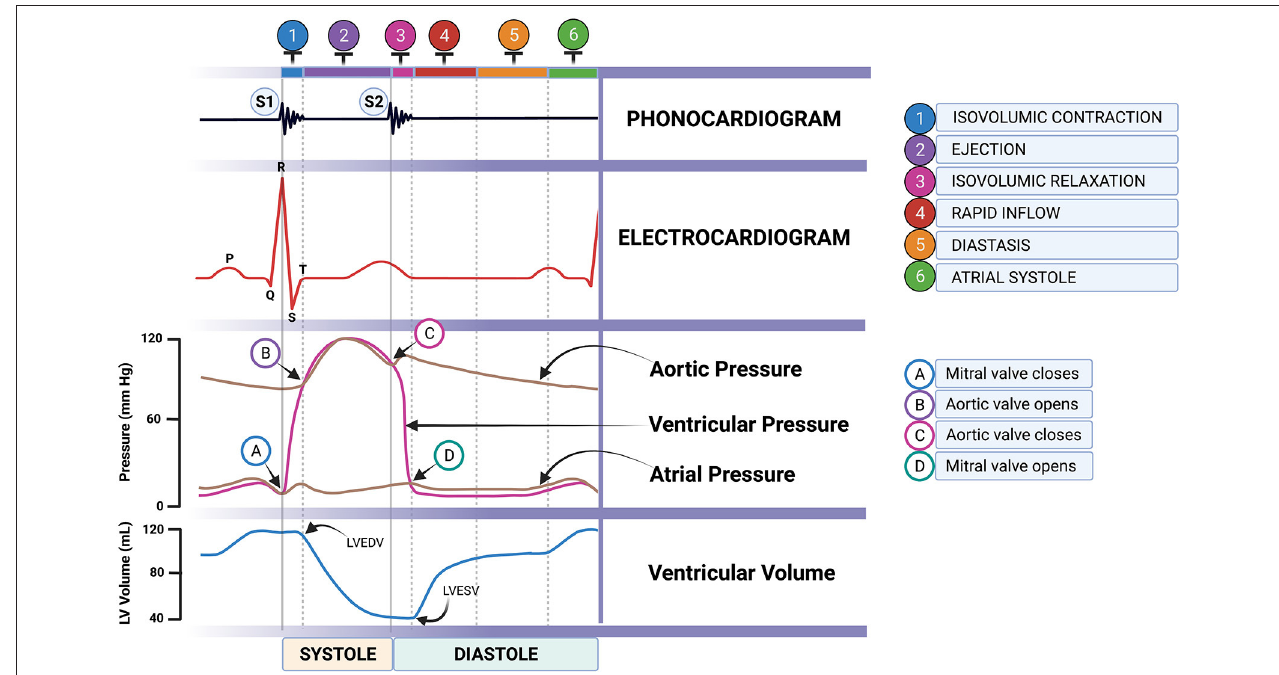
FIGURE 1 | Cardiac cycle through the Wiggers diagram showing the simultaneous ECG and PCG recordings (artist: Bryan James P. Bulatao). PCG, phonocardiography.